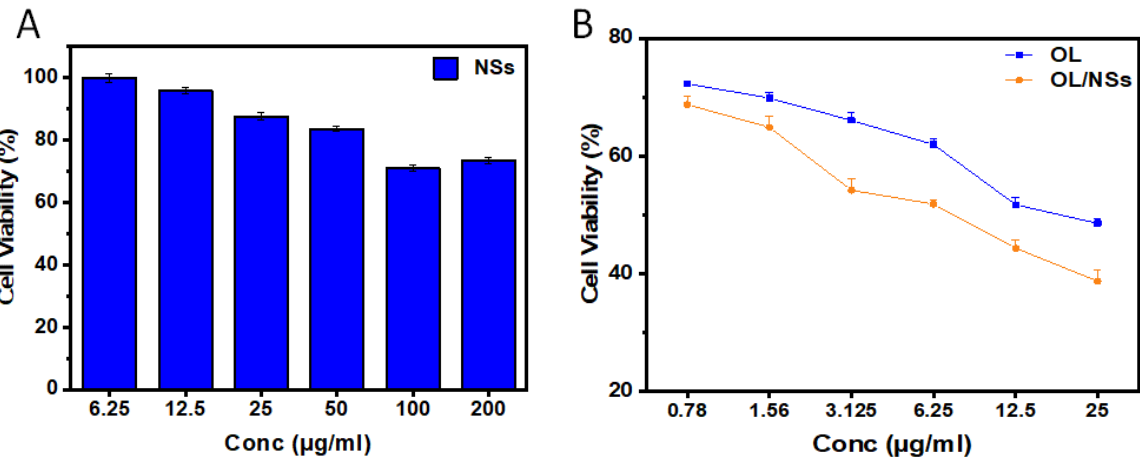
Figure 6. Evaluating the cytotoxicity of ( A ) plain niosomes, ( B ) OL, and OL/NSs on A375 cells at various concentrations using MTT assay. An overall statistically significant decrease in cell viability was observed with OL/NSs compared to free OL ( p < 0.05). Untreated cells were used as negative control and considered as 100%. All experiments were carried out in triplicate, and the mean values were calculated. Error bars represent ± standard